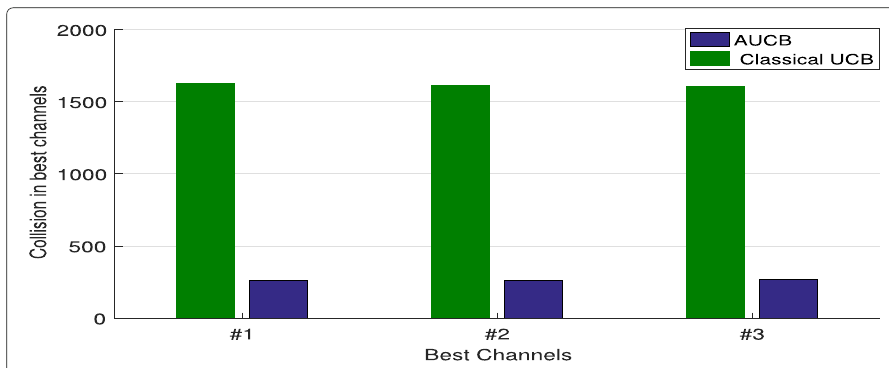
Fig. 6 Number of collisions in the best channels under the random rank